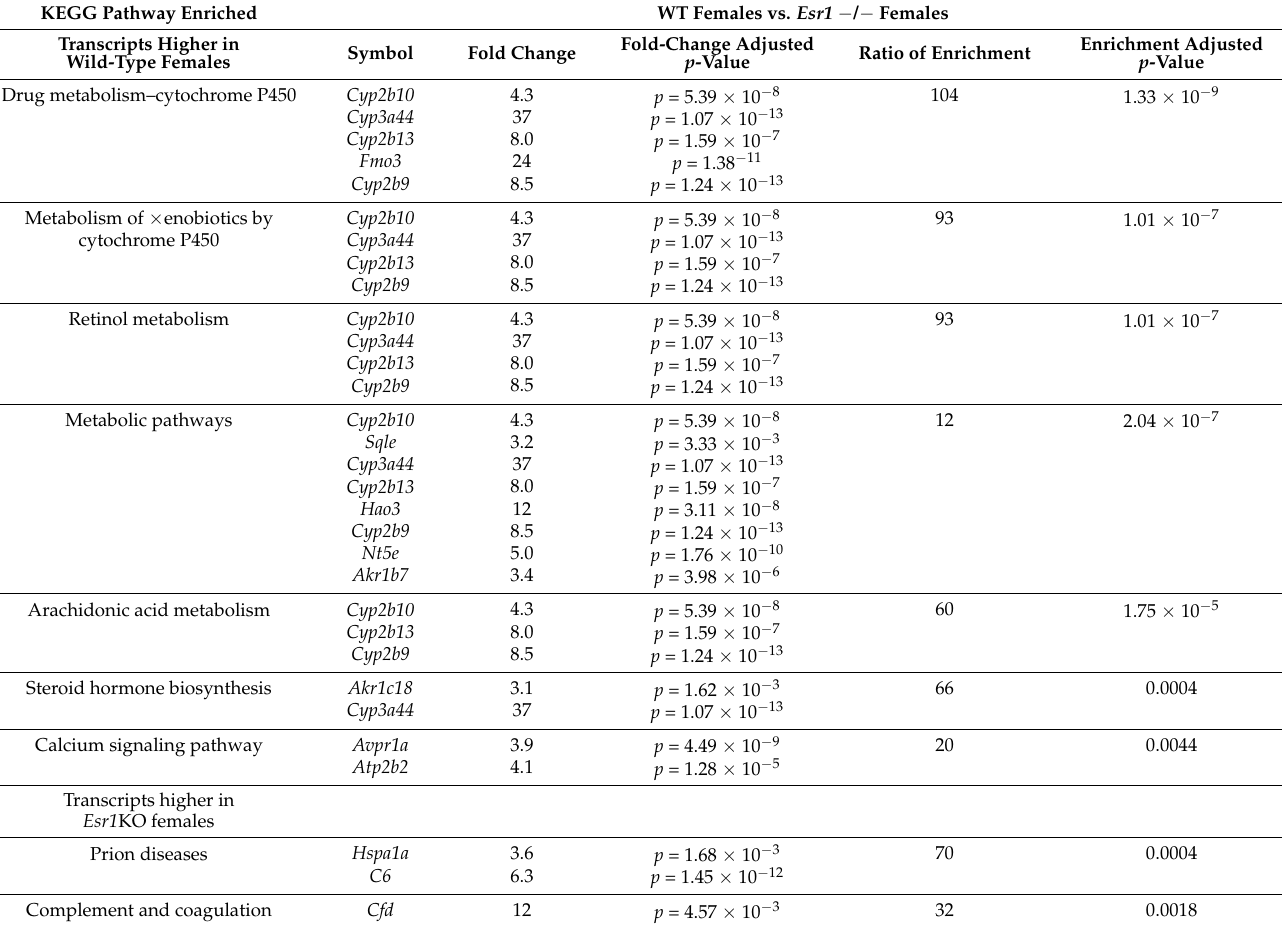
Table 5. KEGG pathway enrichment: Transcripts regulated by Estrogen Receptor- α